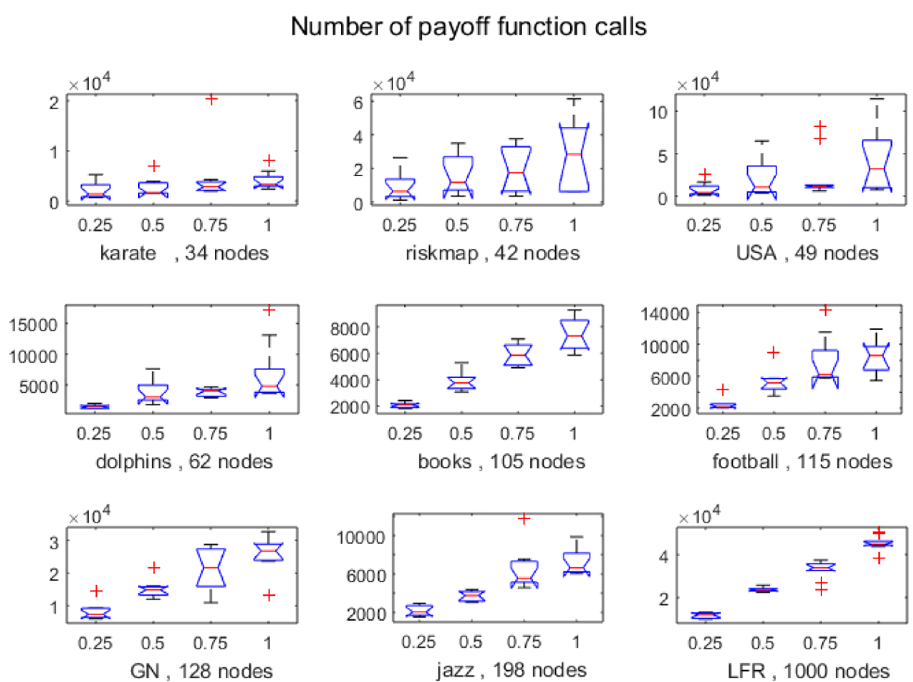
Fig 13. Number of payoff function calls in Alg. 2, 10 individuals. Notches indicateconfidencelimits of the mean.